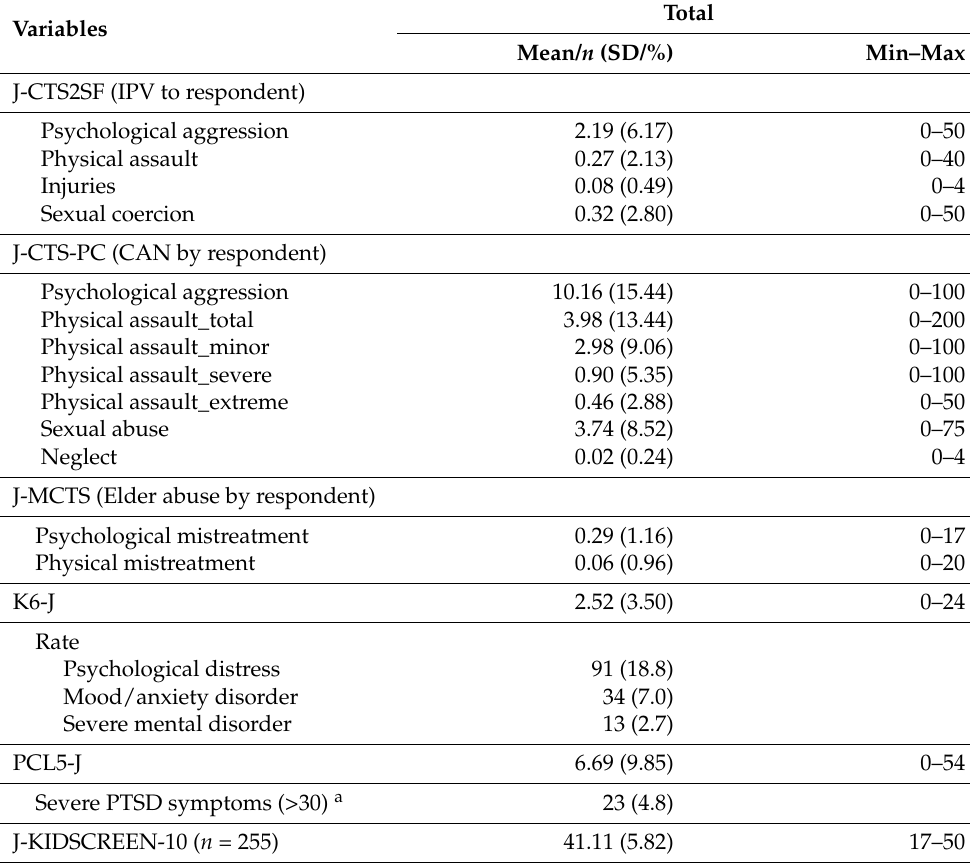
Table 3. Descriptions of the variables used as external criterions ( n =